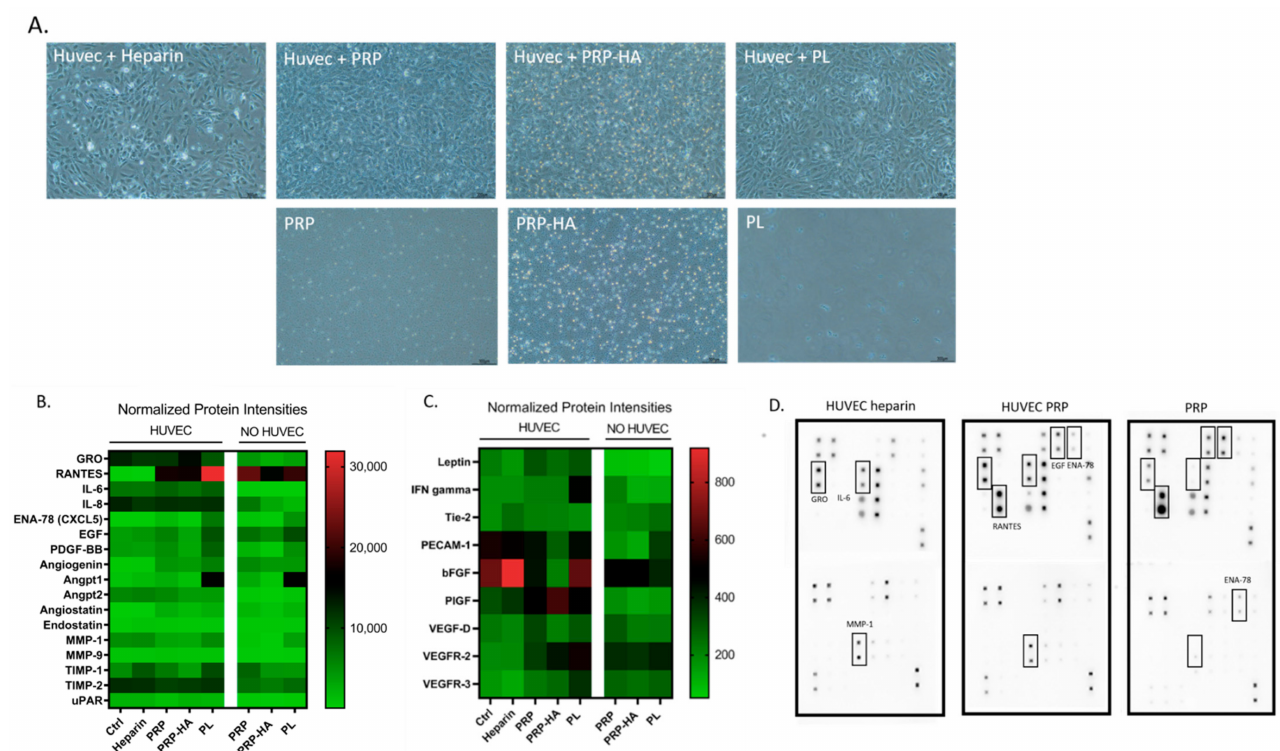
Figure 4. Secretome profiling of angiogenic proteins present in PRP, PRP-HA, and PL preparations and in the medium after culture with HUVEC. ( A ) Representative images of the cultures used to produce conditioned medium for secretome profiling on angiogenesis cytokine arrays. Upper line: HUVEC in the presence of heparin (control medium) or PRP, PRP-HA or PL. Lower line: medium containing PRP, PRP-HA or PL, no cells. Scale bars: 300 µ m. ( B , C ) Heat map analysis representing the average pixel density of the duplicated spots for each angiogenic-related protein highlighted the array quantified by densitometry. Variation in color intensities represents differential secretion of angiogenic proteins by HUVEC, platelet-derived products (PRP, PRP-HA or PL) or the combination of both. ( D ) Example of the human angiogenesis antibody array composed of duplicated spots of 43 angiogenic-related factors performed with cultures supernatants of HUVEC with heparin, HUVEC with PRP or PRP